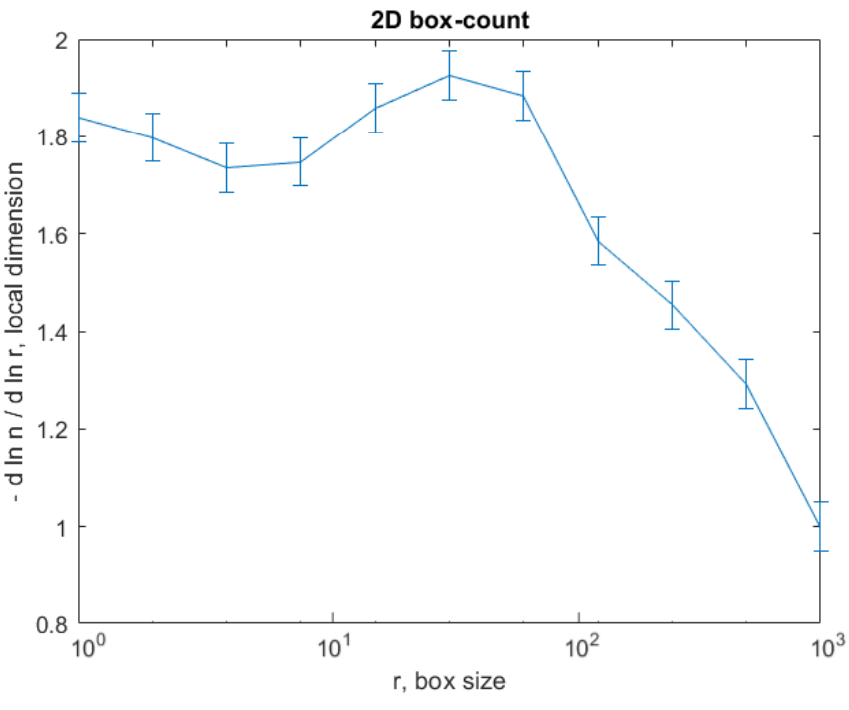
Figure 12. Box-count algorithm results: fractal dimension.